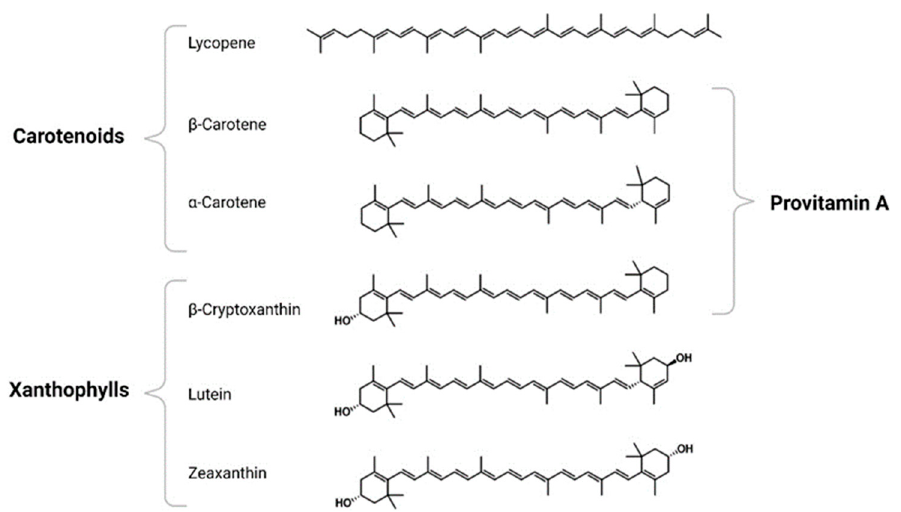
Figure 3. Structure of the reviewed carotenoids. Table 1. Carotenoids content per portion (mg) (Adapted from